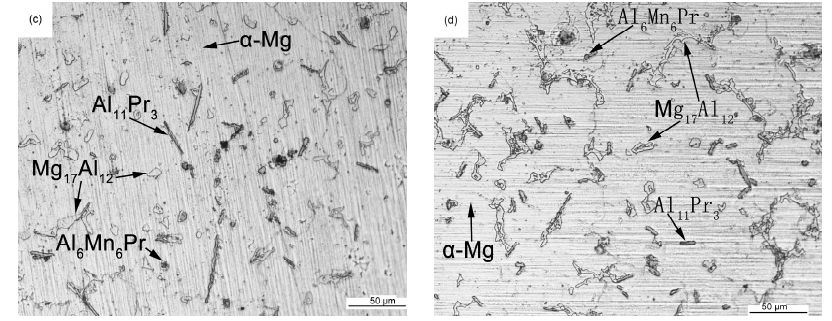
Figure 1. Optical microstructure of the AZ91-xPr alloys: ( a ) x = 0%, ( b ) x = 0.5%, ( c ) x = 1.0% and ( d ) x = 1.5%.